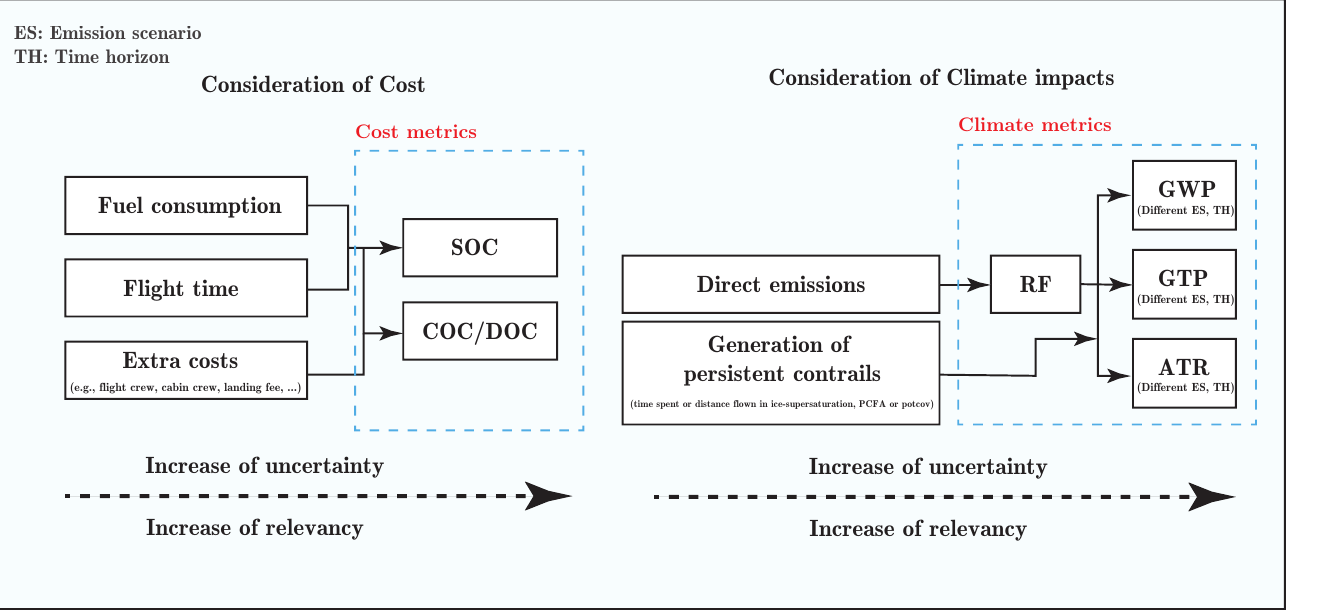
Figure 2. Different objectives usually considered within cost/climate optimal trajectory planning. Each block can be considered as an objective in the objective